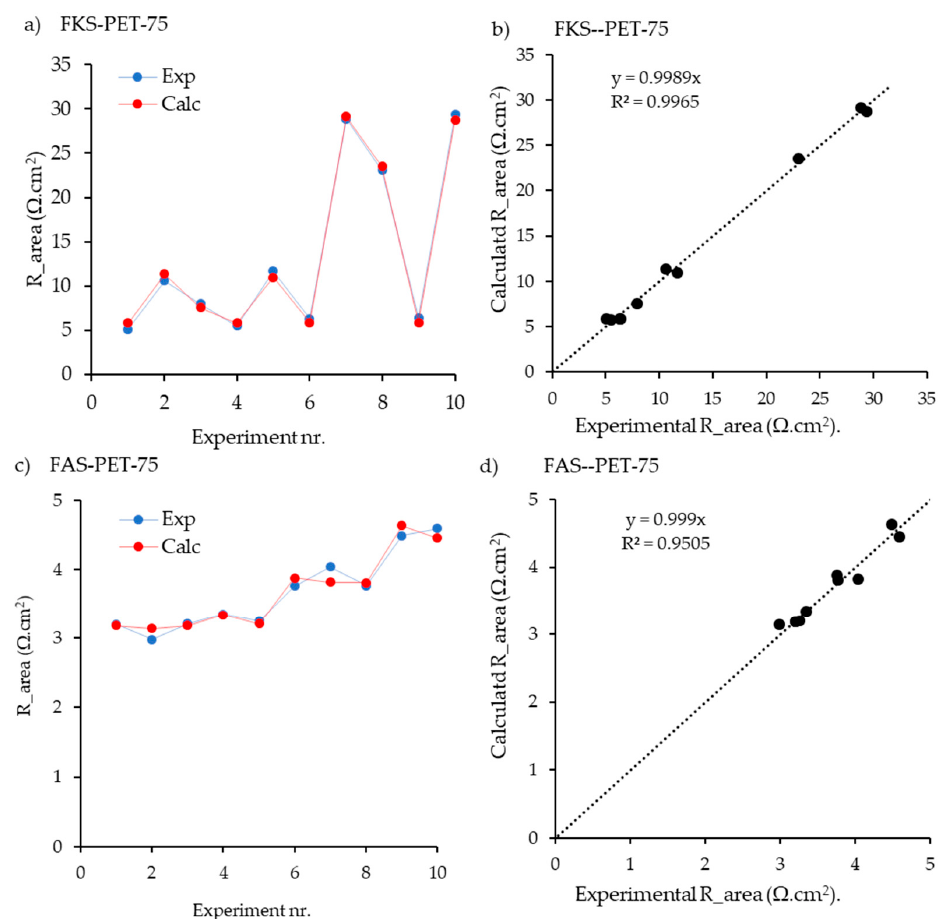
Figure 3. Results of the fitting procedure for the Fumatech membranes FKS-PET-75 ( a , b ) and FAS- PET-75 ( c , d ), with solutions containing NaCl, MgCl 2 , CaCl 2 , and Na 2 SO 4 . The composition of the various solutions is indicated with “Experiment nr.” and refers to Table 2 (data from this publica- tion). In ( a , c ), lines are added to guide the eye; in ( b,d ) the regression lines are shown. On the other hand, membranes with a thickness of 50 µm, FKS-50 and FAS-50 with- out reinforcement, were evaluated, taking the data from Gómez-Coma et al. [22]. In this